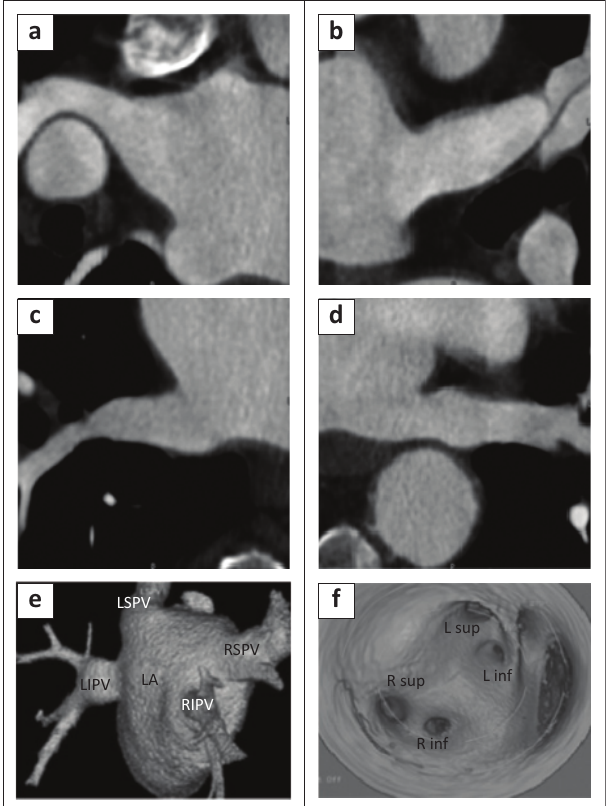
FIGURE 1: Normal pulmonary vein anatomy displayed on long axis reformatted computed tomography images in a 73 year-old man prior to radiofrequency ablation therapy for atrial fibrillation: (a) Right superior pulmonary vein; (b) Left superior pulmonary vein; (c) Right inferior pulmonary vein; (d) Left inferior pulmonary vein; (e) Three-dimensional models of normal left atrium and pulmonary vein anatomy showing the right superior pulmonary vein (RSPV), right inferior pulmonary vein (RIPV), left superior pulmonary vein (LSPV), left inferior pulmonary vein (LIPV) and left atrium (LA); (f) Endocardial views of the left atrium and pulmonary veins showing normal anatomy with the right superior pulmonary vein (R sup), right inferior pulmonary vein (R inf), left superior pulmonary vein (L sup) and left inferior pulmonary vein (L inf), with annotation of each pulmonary vein